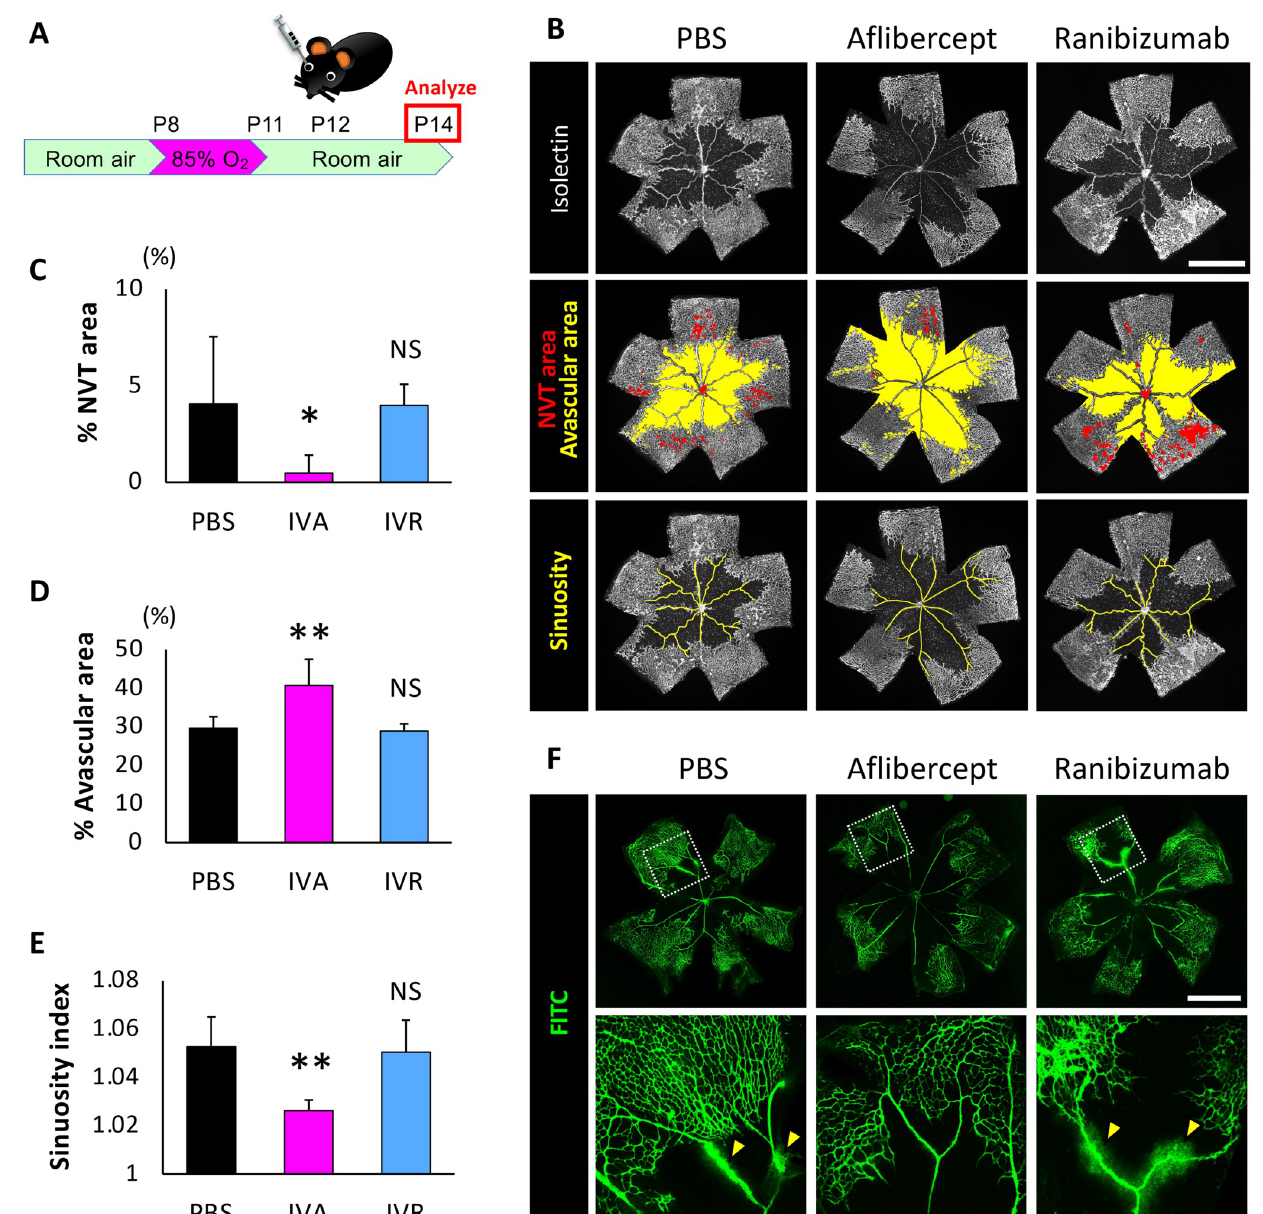
Fig 1. The effect of intravitreal injection of ranibizumab and aflibercept on oxygen induced retinopathy. (A) A schematic diagram depicting the time course of our experiment. (B) Whole-mounted stained retinas on day 2 after injection. (C) The reduction of the NVT area was observed in aflibercept injected eyes, but not in ranibizumab injected eyes. (D) Avascular area enlargement was observed in aflibercept injected eyes, but not in ranibizumab injected eyes. (E) Decreased sinuosity of the retinal vessel was observed in aflibercept injected eyes, but not in ranibizumab injected eyes. (F) Retinal vascular permeability was suppressed in aflibercept-treated eyes, but not in ranibizumab-treated eyes (arrowheads). Scale bars represent 1000 μ m (B and upper row of F); 200 μ m (lower row of F); �� P < 0.01; � P < 0.05 (n = 7 /group). Data are presented as mean ± SD. PBS, phosphate-buffered saline solution; IVA, intravitreal aflibercept; IVR, intravitreal ranibizumab; NVT, neovascular tuft; NS, not significant. https://doi.org/10.1371/journal.pone.0278951.g001 After 4 intraperitoneal injections of PBS (n = 7), aflibercept (10 mg/kg, n = 6), or a low (2.5 mg/kg, n = 6) or high (10 mg/kg, n = 6) dose of ranibizumab, body weight gain in pups treated with aflibercept was significantly impaired comparing with other three groups ( P < 0.01, Fig 2B). The body weight gain in pups treated with 2.5 mg/kg or 10 mg/kg of ranibizumab was